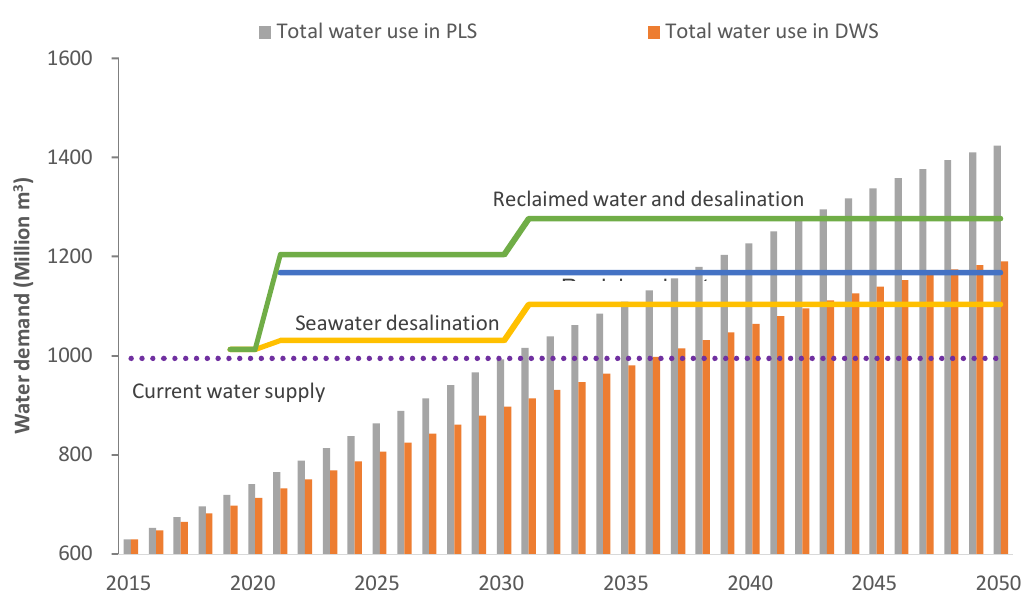
Figure 7. Projected future Xiamen City water supplies and water demand considering only local water sources. Note: PLS is the acronym for planning scenario; DWS is the acronym for double water-saving scenario.